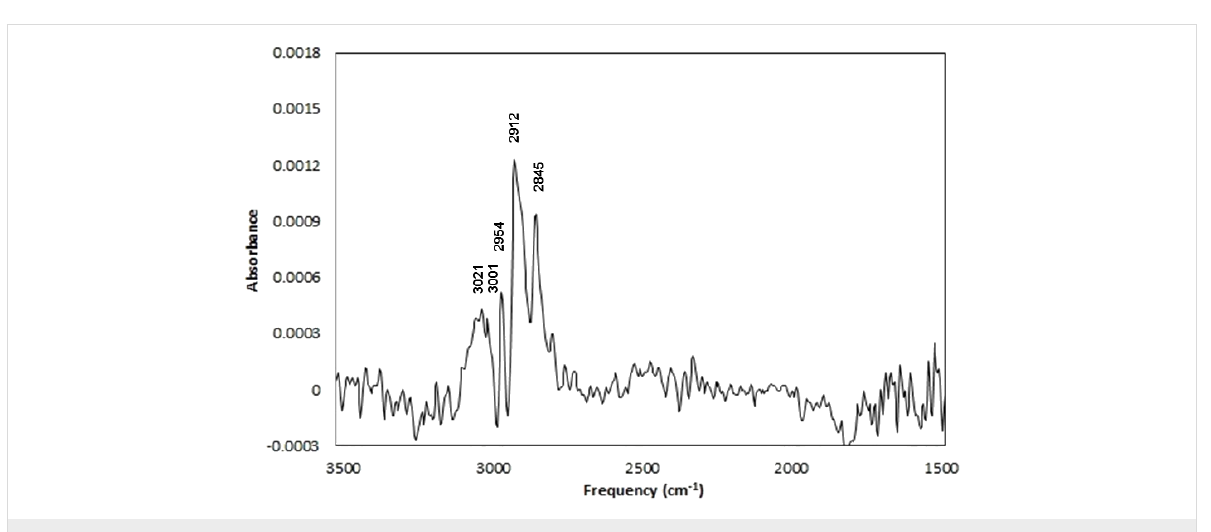
Figure 6: IRRAS Spectrum of Au–Me.